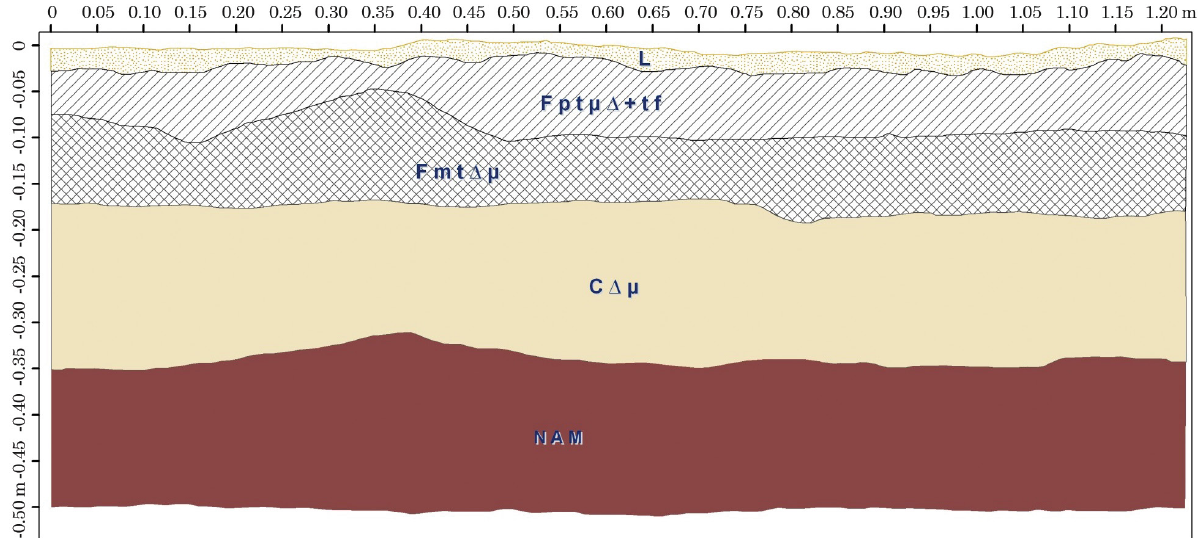
Figure 1. Schematic representation of the different organizations of the crop profile under the Memory plot. L: volume of loose soil, not compact, “powdered”; F or C: fragmented or continuous volumes of soil; ∆μ or μ∆: compact or porous clods, with very compact aggregates (∆), compact (∆μ) and in compaction process (μ∆); pt, mt, gt: small, medium or large clods; tf: fine soil; and NAM: not altered by